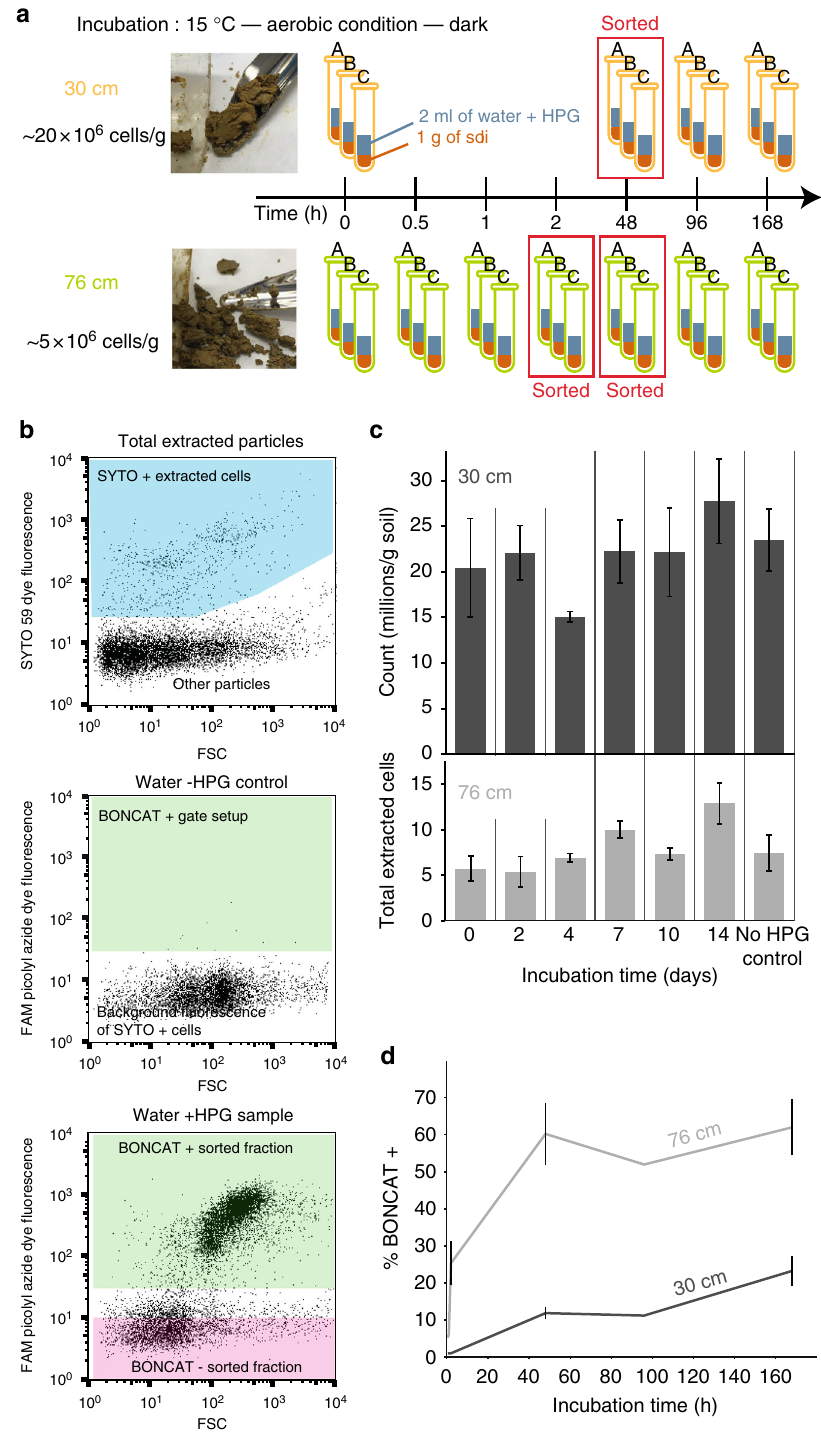
Fig. 1 Performing BONCAT-FACS on soil samples. a Details of the incubation conditions of the 76 cm and 30 cm soil samples. Samples were incubated in triplicate and three time points were sorted. b The gate drawing was done in two steps, fi rst the cells were separated from the background particles based on their DNA dye staining SYTO59 fl uorescence (Ex: 640 nm/Em: [655 – 685 nm]), as pictured by the blue gate on the top panel. The SYTO + cells were further analyzed for their BONCAT fl uorescence with the FAM Picolyl dye (Ex: 488 nm/Em: 530 nm). The middle panel shows an example of a control sample that was water incubated and clicked (water – HPG control), the BONCAT gate (in green) was set such that less than 0.5 % of events would fall in that gate (false positive). The bottom panel is an example of how the BONCAT + and BONCAT – gates where set in a HPG incubated sample. Note that the green gate is the same than in the control sample. c Total extracted cell counts over time showing ~20 million cells per gram at 30 cm and ~5 million cells per gram at 76 cm. d Temporal dynamics of BONCAT + (express as a percent of the extractable cells) labeling for the 30 cm and the 76 cm sample. Error bars represent standard deviation ( n =